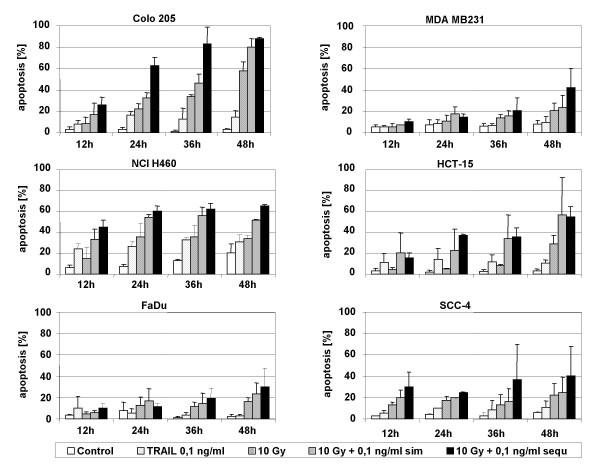
Time course of induction of apoptosis in six solid tumour cell lines. Apoptosis was determined by microscopic evaluation of Hoechst stained cell nuclei 12 to 48 h after treatment with TRAIL 0,1 ng/ml and 10 Gy alone, and after simultaneous and sequential application of combined therapy. Data represent means of three independent experiments; bars ± SD